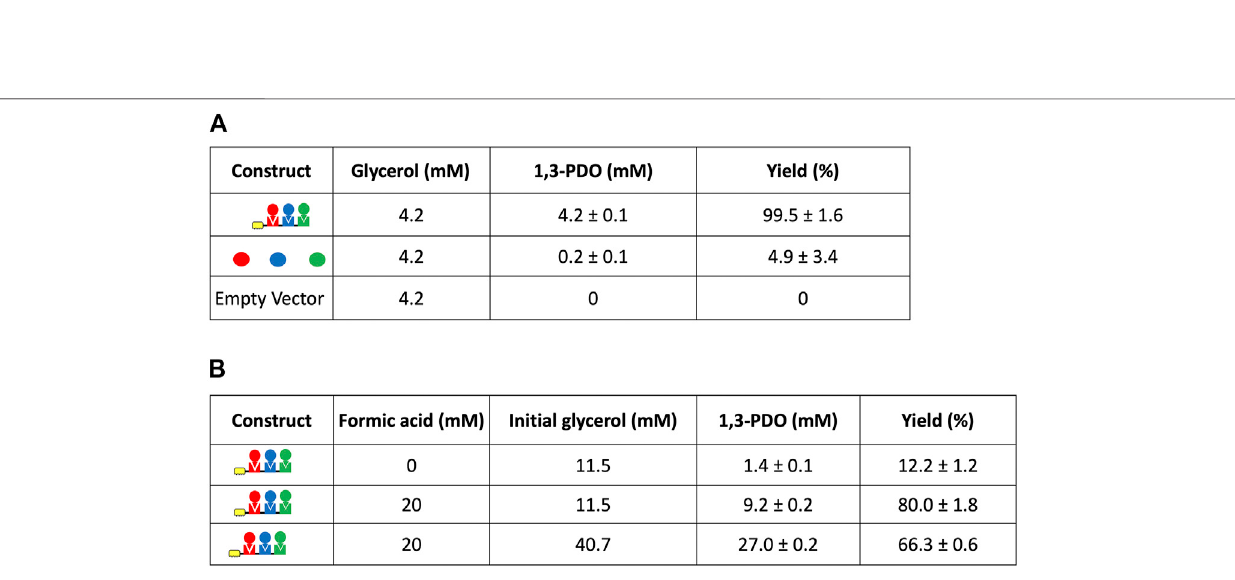
Frontiers in Energy Research |